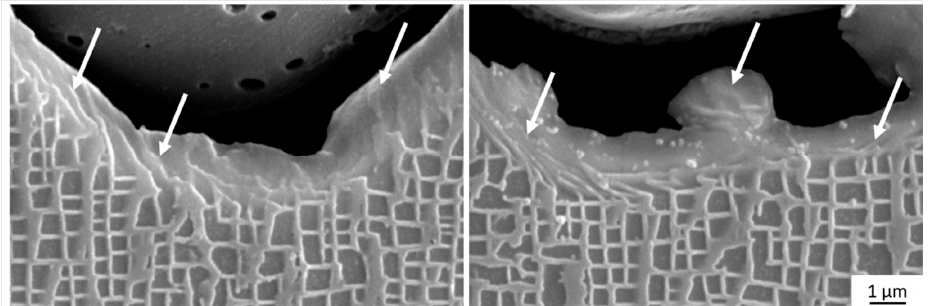
Figure 14. Microstructure at the bottom holes of two patterns 1 textured on AM1 + AgT.